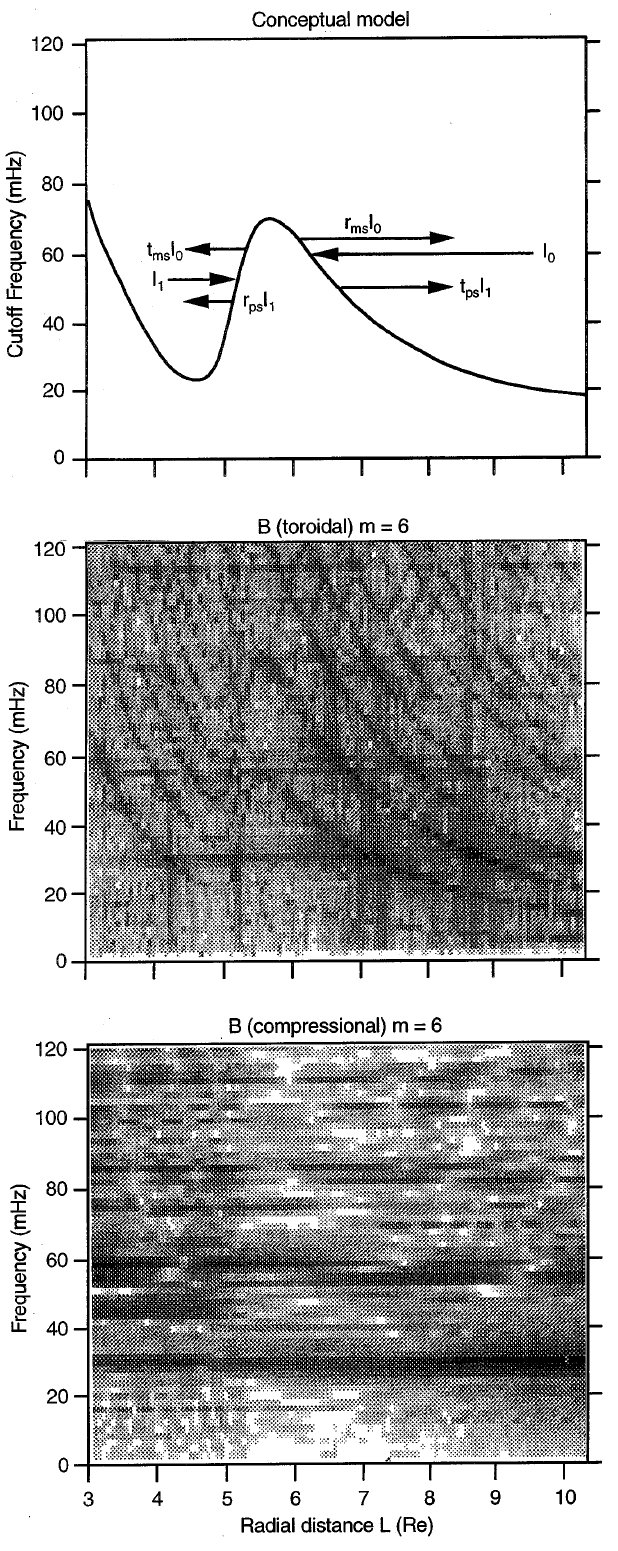
Fig. 7. Conceptual model ( top ) and the simulation results ( middle and bottom ) of magnetospheric ULF response to externally applied stimuli (adapted from Fig. 7 and 8 of